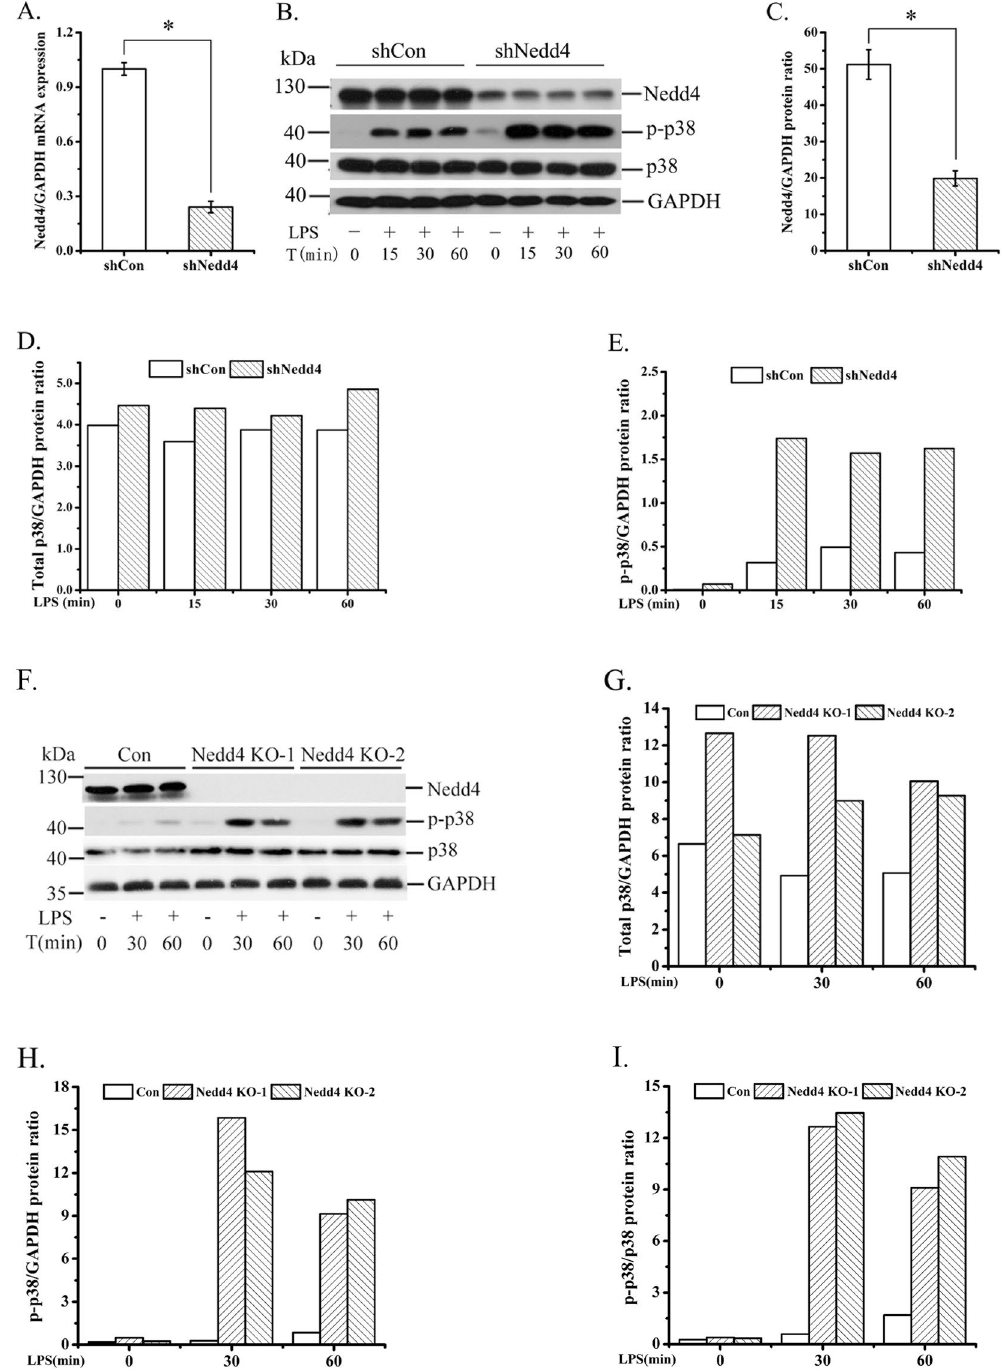
Figure 1. Nedd4 deficiency enhances p38 α , especially p-p38 α protein levels. ( A , C ). mRNA and protein level of Nedd4 are decreased in iBMDM cells with lentiviral-based shRNA. ( A ) iBMDM cells transduced with control or shRNA targeting to Nedd4 were collected and the total RNA was extracted with TRIzol, reverse transcribed, and analyzed for Nedd4 mRNA with Q-PCR. ( B , F ). The p38, especially p-p38 protein levels were increased in Nedd4 deficient iBMDM cells stimulated for 0-60 min (above lanes) with LPS. ( B ) iBMDM cells transduced with control or shRNA targeting to Nedd4 were subjected to immunoblot analysis. ( F ) Immunoblot analysis of Nedd4 knockout (Nedd4 − / − ) iBMDM cell lines. ( C – E ). ImageJ analysis for the immunoblot of Nedd4, total p38 and p-p38 levels in iBMDM cells transduced with control or shRNA targeting to Nedd4. ( G – I ) ImageJ analysis for the immunoblot of total p38 and p-p38 levels in two Nedd4 − / − iBMDM cell lines. The results are represented from at least three independent